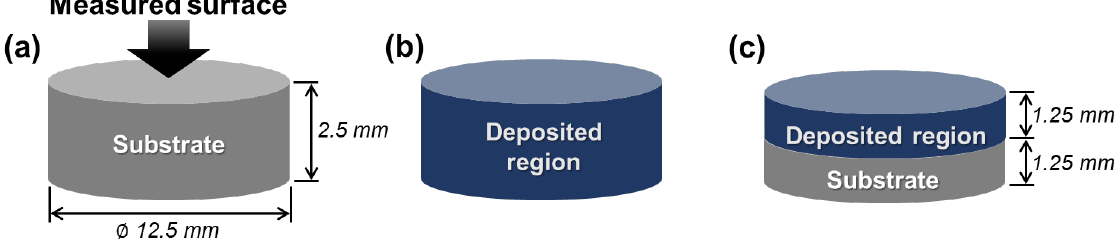
Figure 5. Schematics of test specimens for the measurement of thermal diffusivity. ( a ) H13 substrate. ( b ) As-deposited HTCS150. ( c ) HTCS150 deposited on H13 substrate.